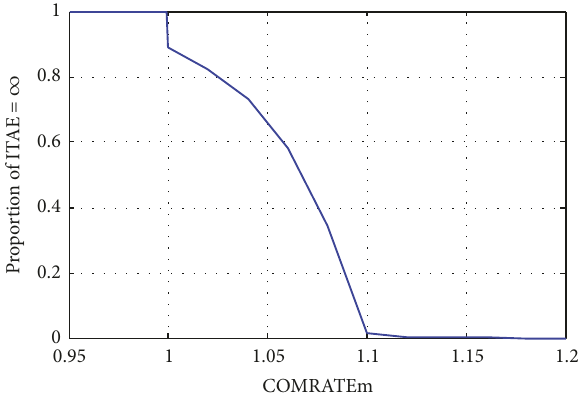
Figure 10: Proportion of ITAE = ∞ in nonlinear HCS with different COMRATE m